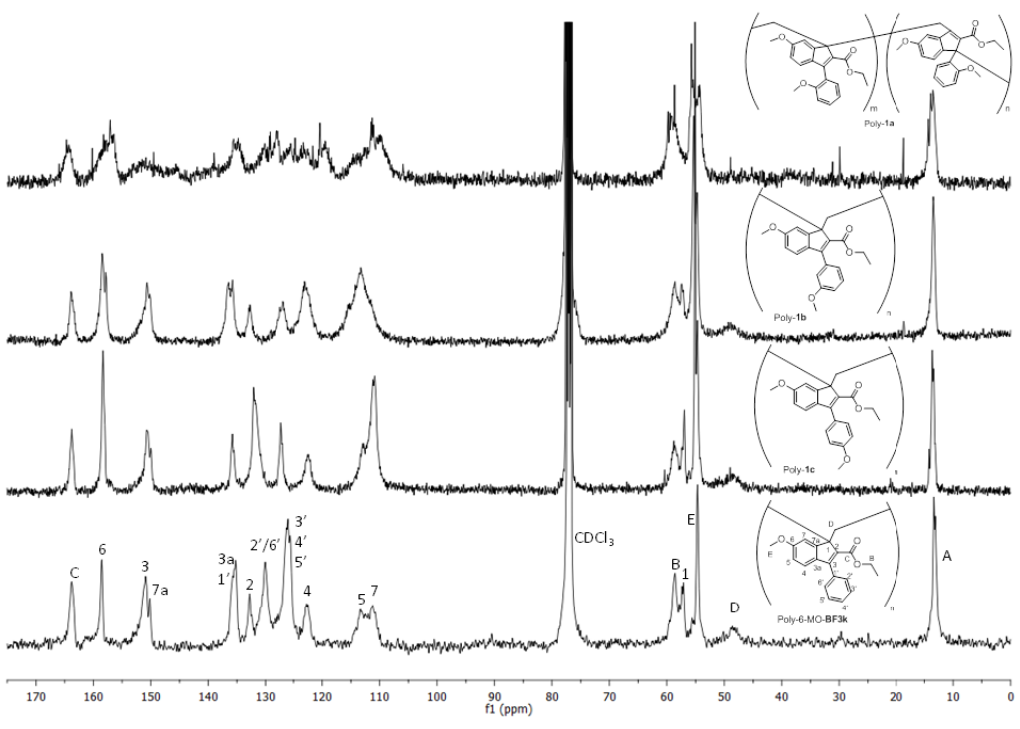
Figure 5. Comparison of the 13 C NMR spectra (CDCl 3 ) of poly- 1a – c with that of the previously reported poly-6-MO- BF3k [49].